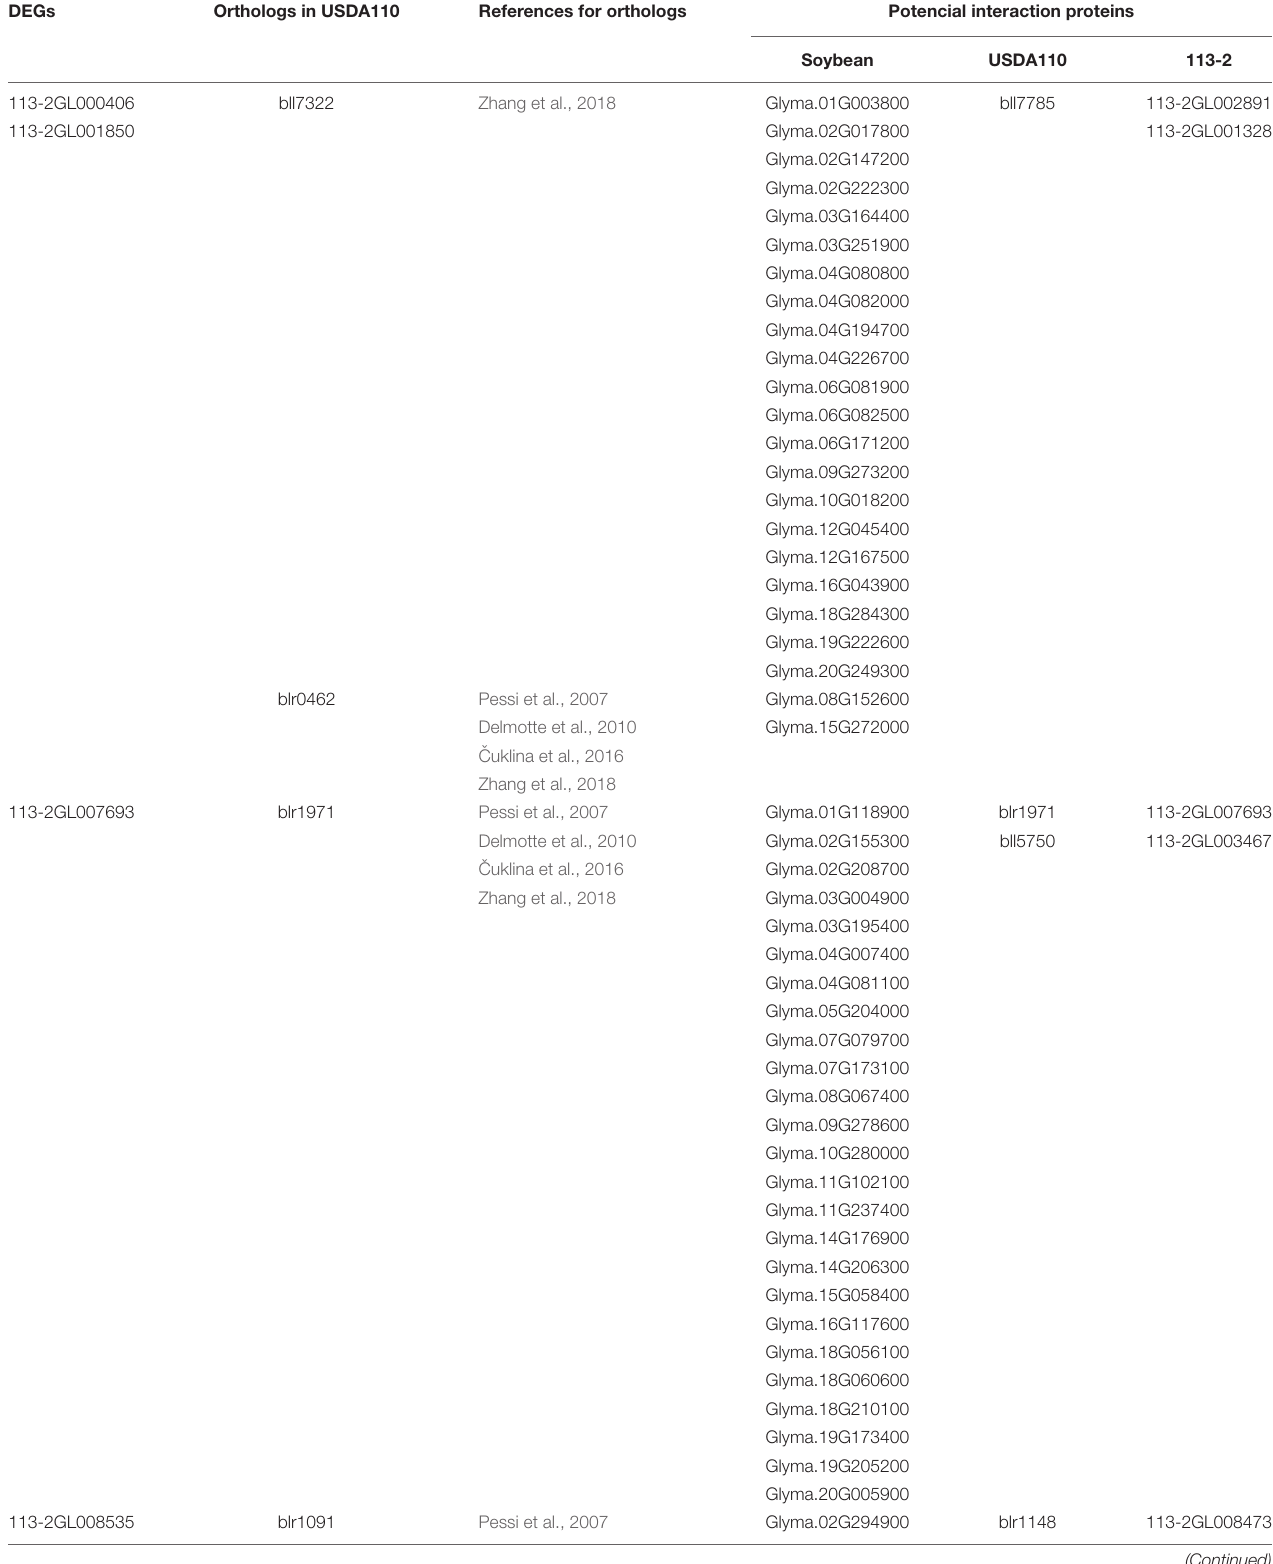
TABLE 4 | The prediction of the interaction proteins of the selected DEGs.